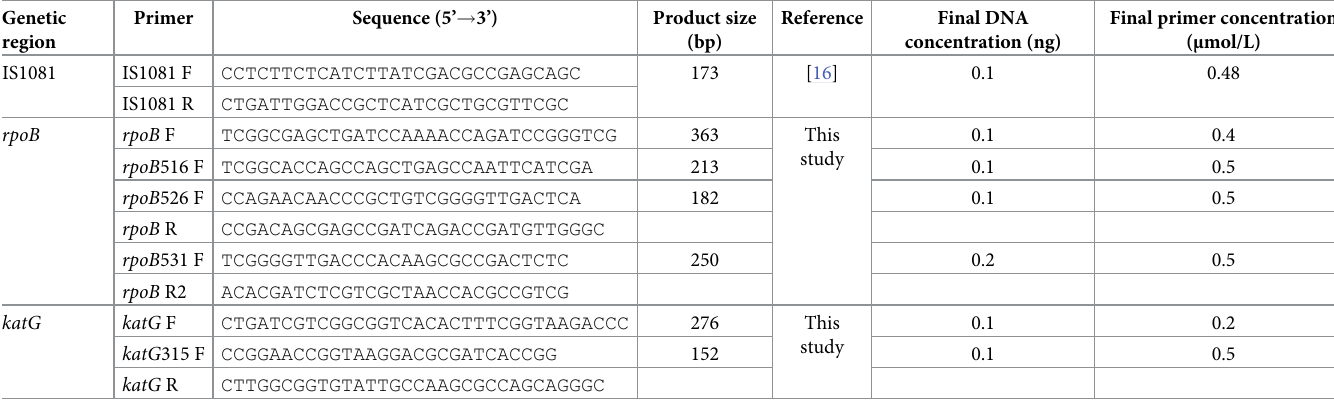
Table 2. RPA primer sequences and optimum conditions used in this study. Genetic